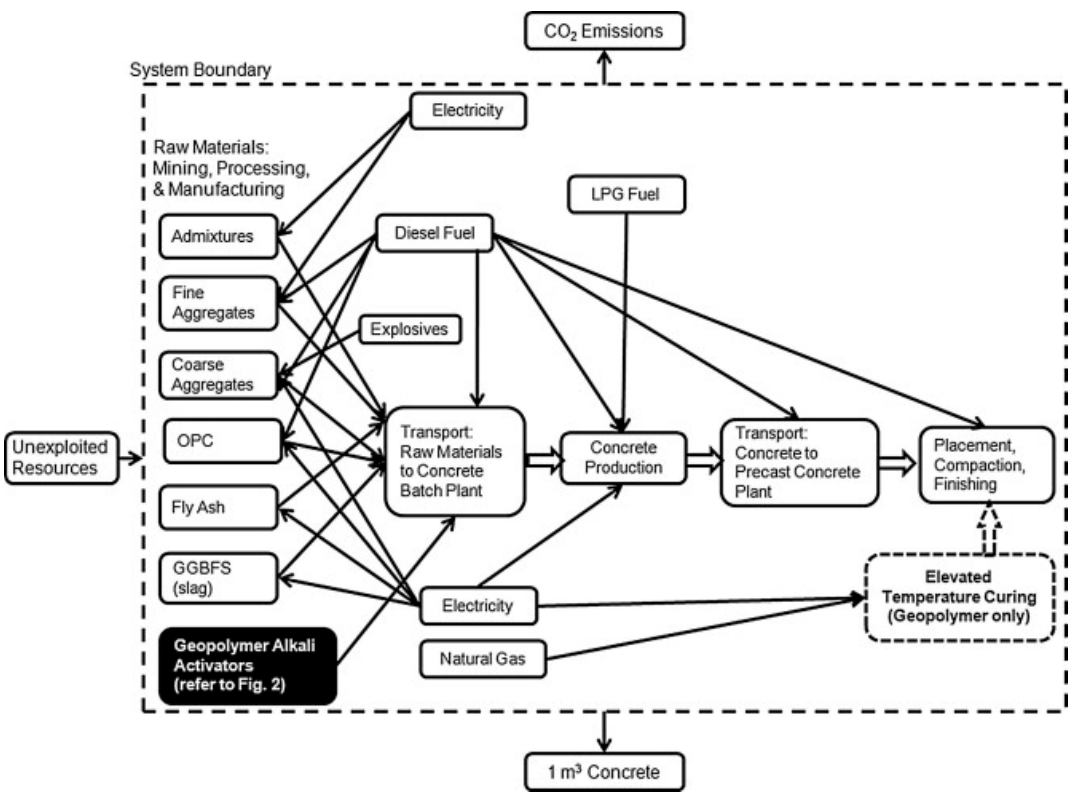
Figure 36. CO 2 emission resulting from GPC [222].